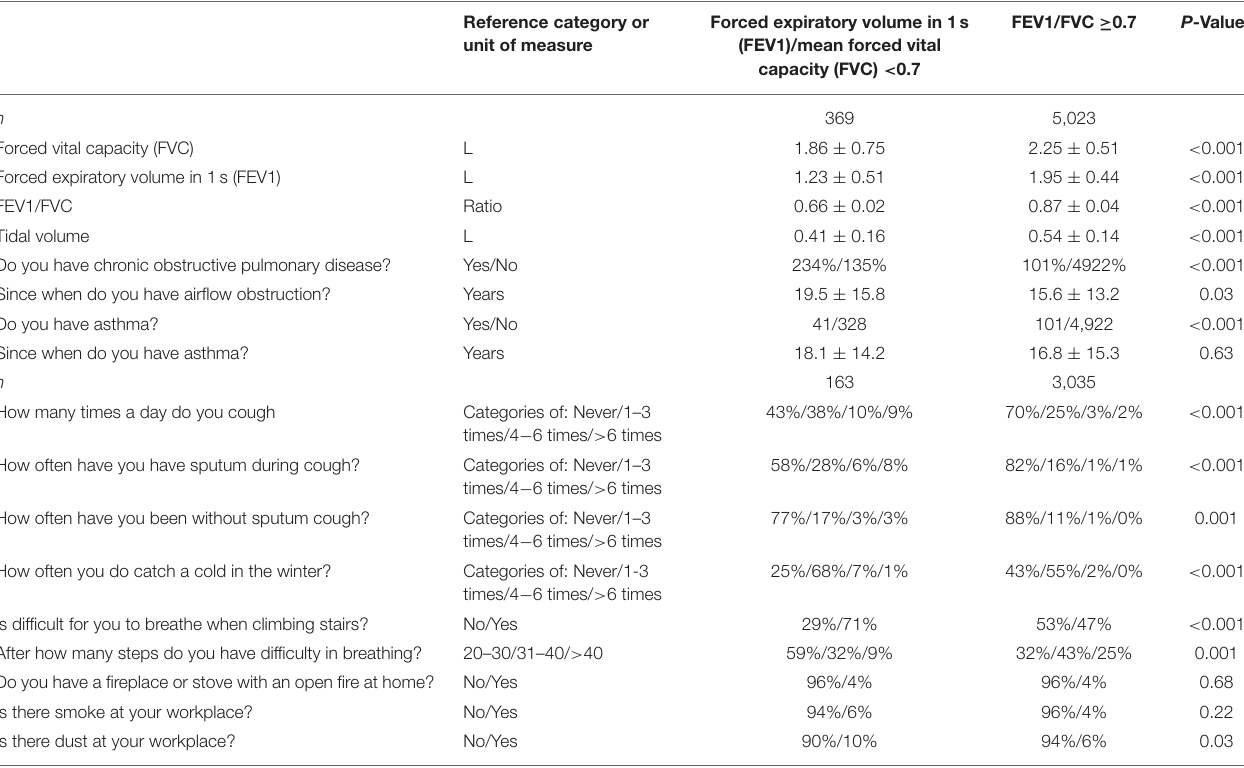
TABLE 1 | Spirometric measurements and clinical signs of airflow obstruction (mean ± standard deviations; frequency and 95% confidence intervals) in the Ural Eye ad Medical Study stratified by the presence of airflow obstruction (defined by a ratio of forced expiratory volume in 1s divided by the mean forced vital capacity of <